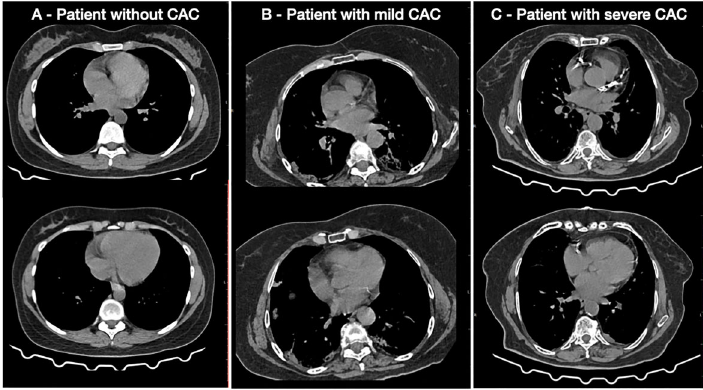
Figure 2. Coronary calci fi cation in chest computed tomography scans. A , Examples of a patient without coronary artery calci fi cation (CAC), B , a patient with mild CAC (presence of calci fi cation in two coronary segments), and C , a patient with severe CAC (presence of calci fi cation in six coronary